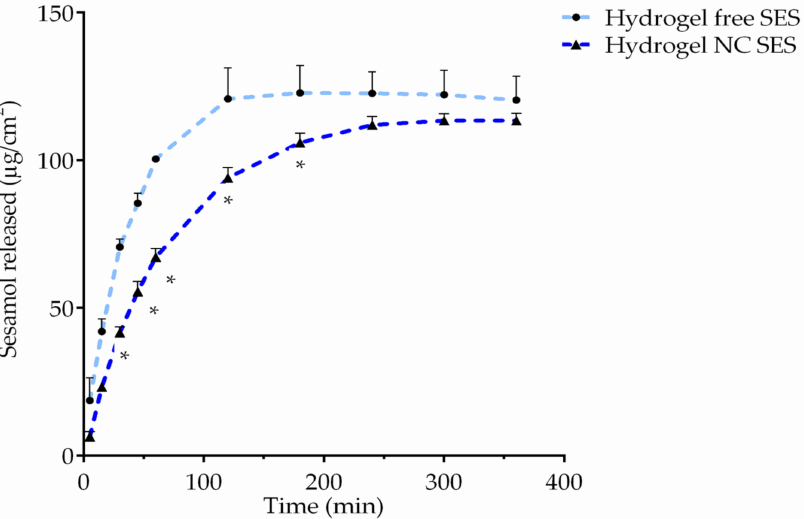
Figure 7. In vitro release profile of the hydrogels containing sesamol in the free (Hydrogel free SES: light-blue line) or nanoencapsulated forms (Hydrogel NC SES: blue line). The experiment was performed in triplicate for each hydrogel, and the values are reported as the mean ± SD. All data were analyzed using the unpaired Student’s t -test at each point (individual time). The asterisks (*) denote a significant difference between the Hydrogel NC SES and Hydrogel free SES (* p <